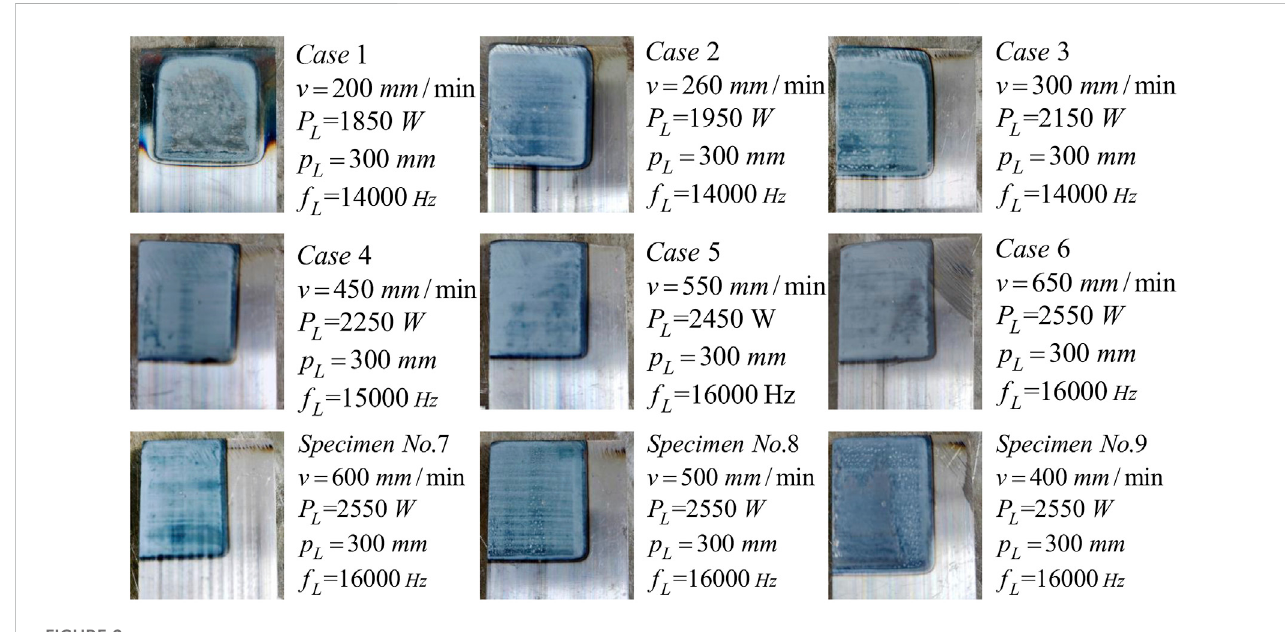
FIGURE 2 Actual morphology of 9 specimens after laser quenching.